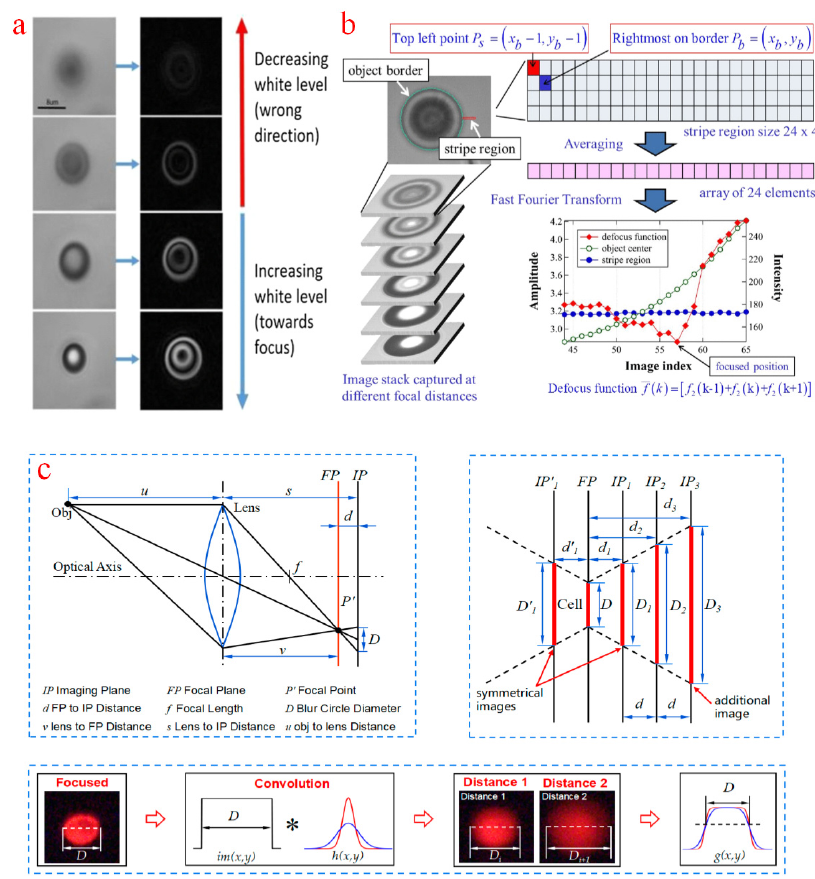
Figure 9. Autofocusing methods. ( a ) An autofocusing method based on a Prewitt operator. Adapted with permission from Reference [154]; (b) An autofocusing method based on the depth from border intensity variation. Adapted with permission from Reference [155]; ( c ) Multiple depth estimation from defocus method. Adapted with permission from Reference [157].